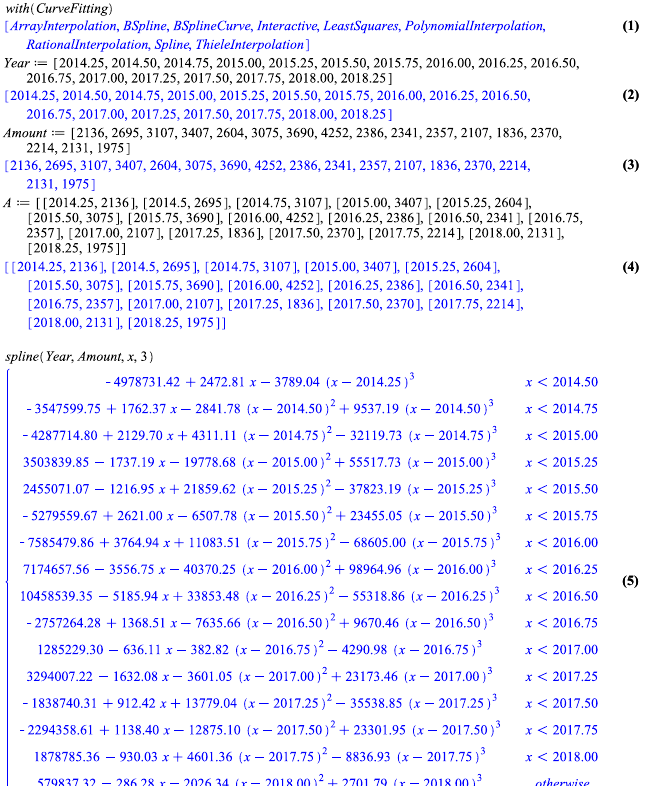
Figure 4. Practical realization of finding the predictive function by the method of splines